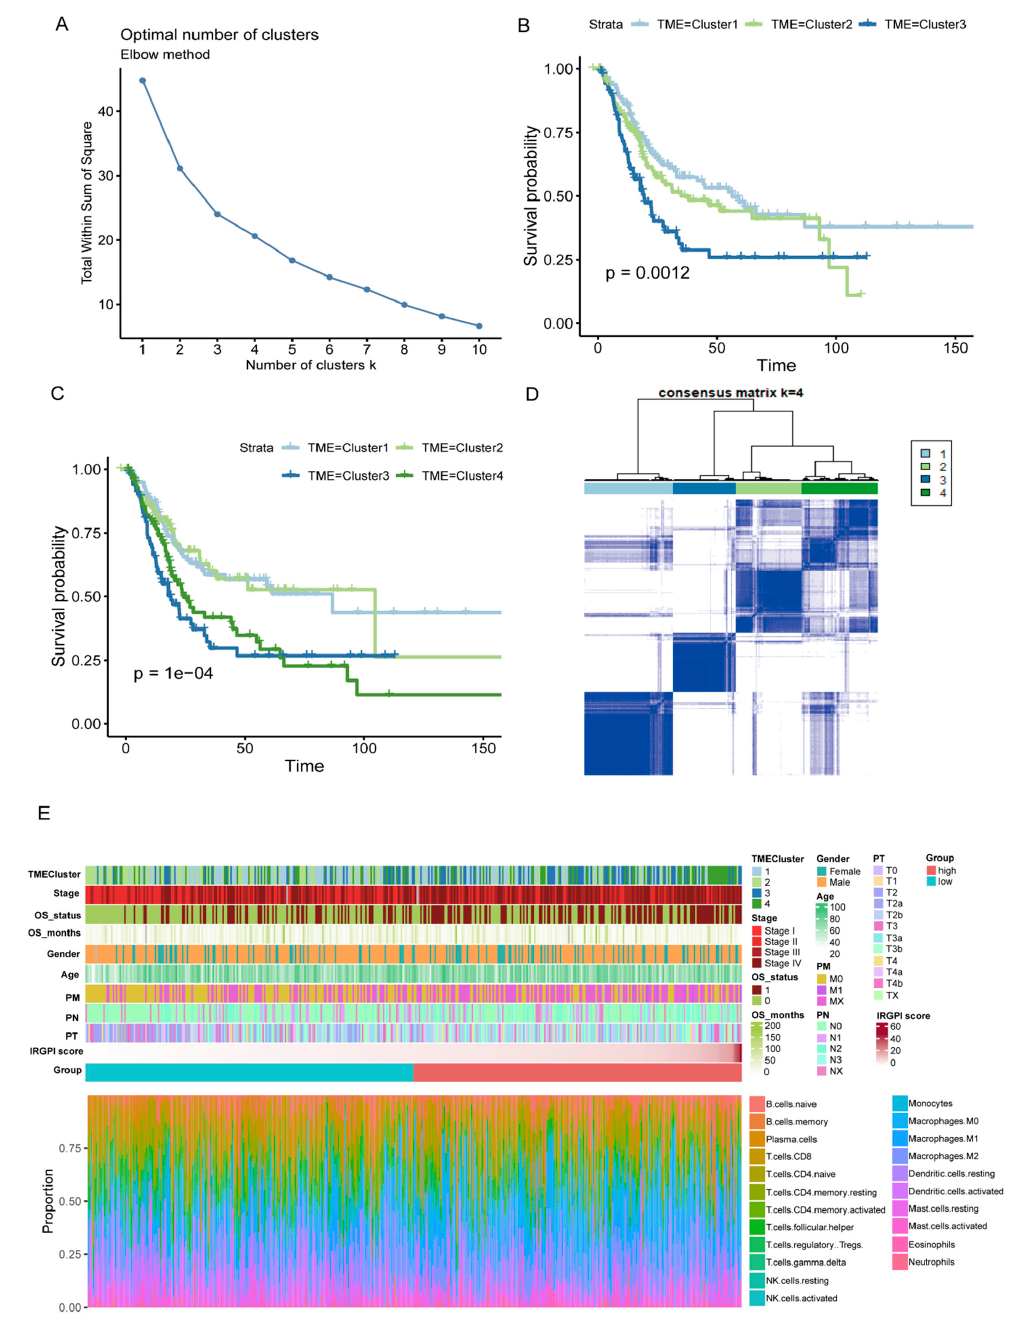
Figure 6. Characterization of TME subtypes and landscape of BC. ( A ) Elbow method to find the best cluster K value. ( B , C ) Kaplan–Meier survival curves from TCGA cohort with the TME infiltration classes (K = 3 and 4). ( D ) Consensus matrix (K = 4). ( E ) Construction of BC landscape based on the prognostic index, the unsupervised clustering of TME, the infiltration ratios of immune cells, and clinical information.